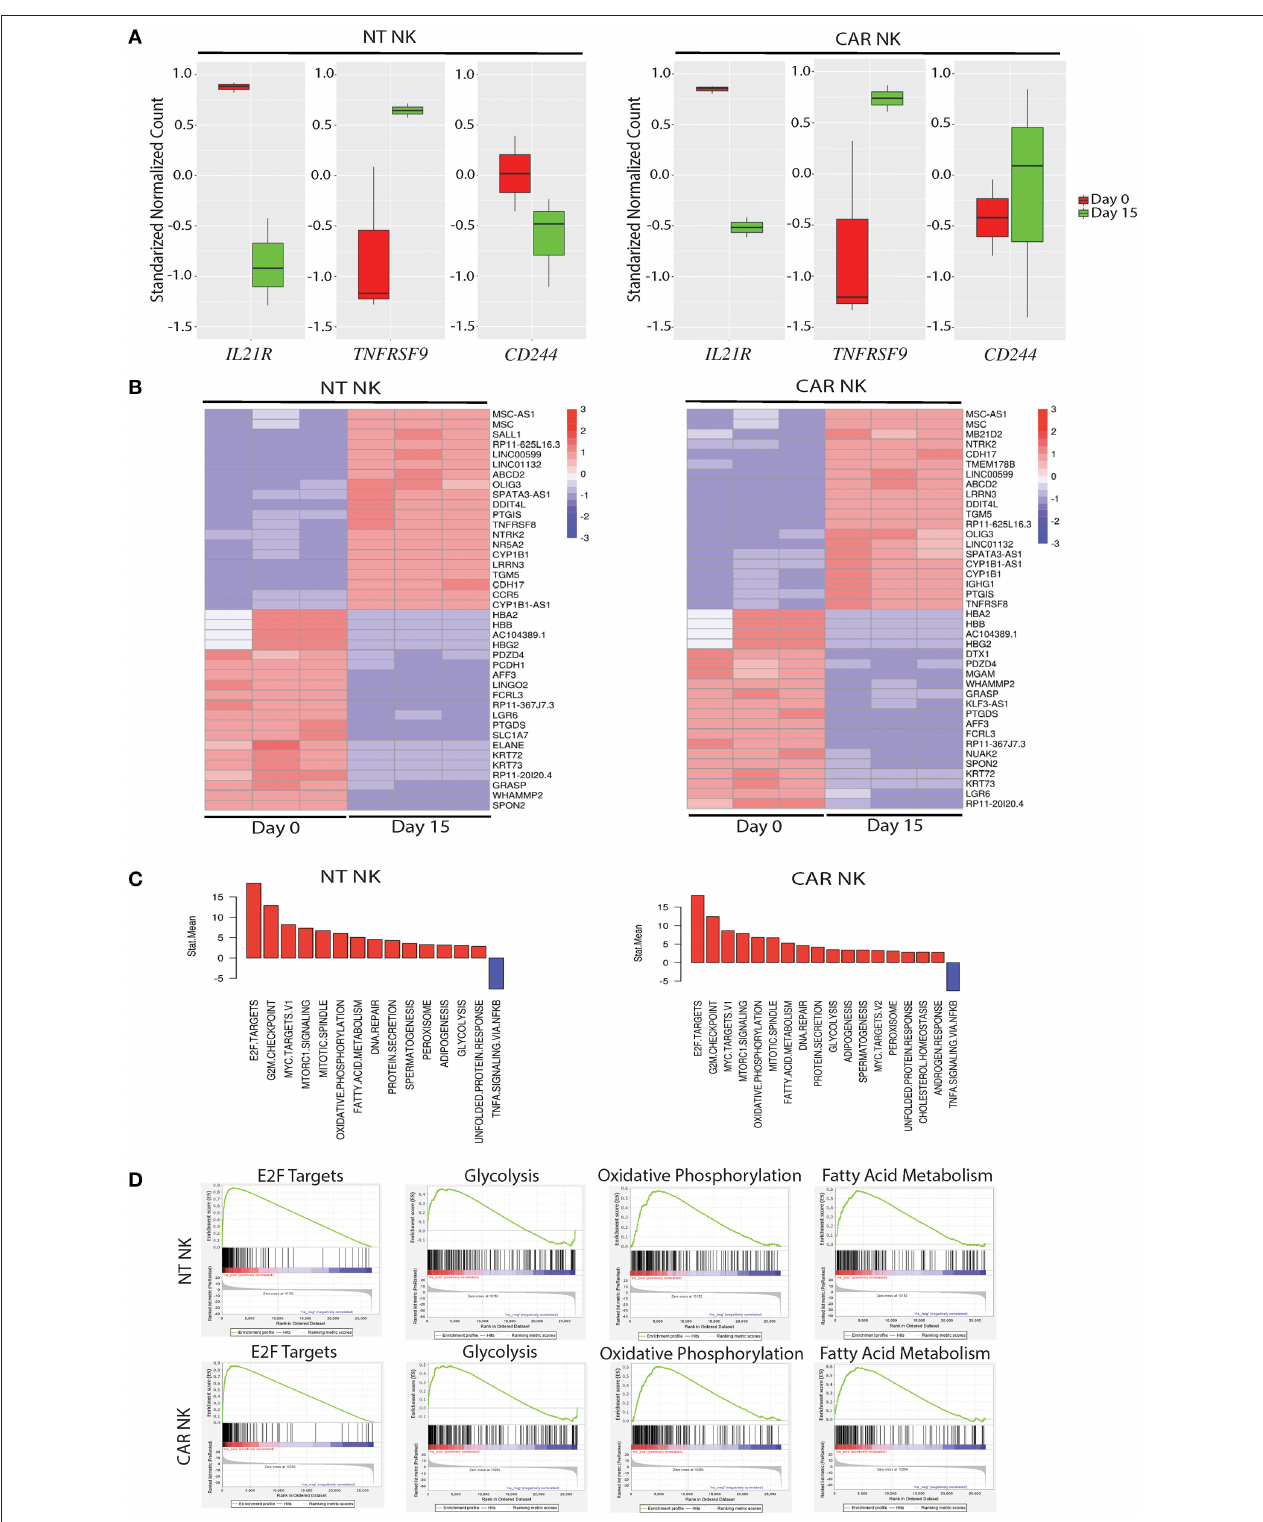
FIGURE 4 | Molecular characterization of uAPC-expanded NT and iC9/CAR19/IL-15 NK cells. (A) RNA sequencing data showing standardized normalized counts of Interleukin 21 Receptor ( IL21R ), TNF Receptor Superfamily Member 9 ( TNFRSF9 ; CD137; 4-1BB ) and CD244 (2B4) genes of NT (left) or iC9/CAR19/IL-15 (CAR) NK